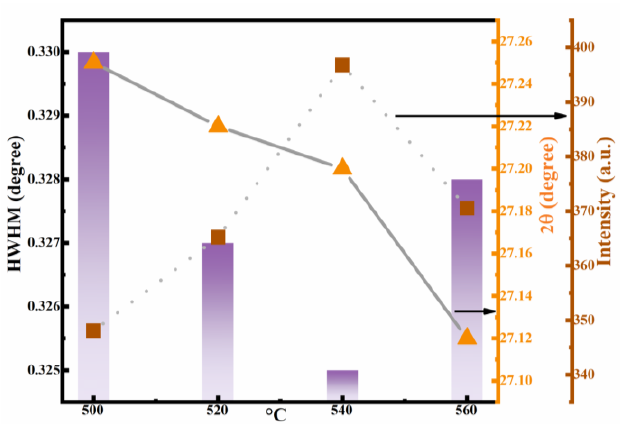
Figure 2. ( a ) XRD patterns of the CNZTSSe films selenized at 500 °C, 520 °C, 540 °C, and 560 °C; ( b ) enlarged images of (112) peaks of all films.